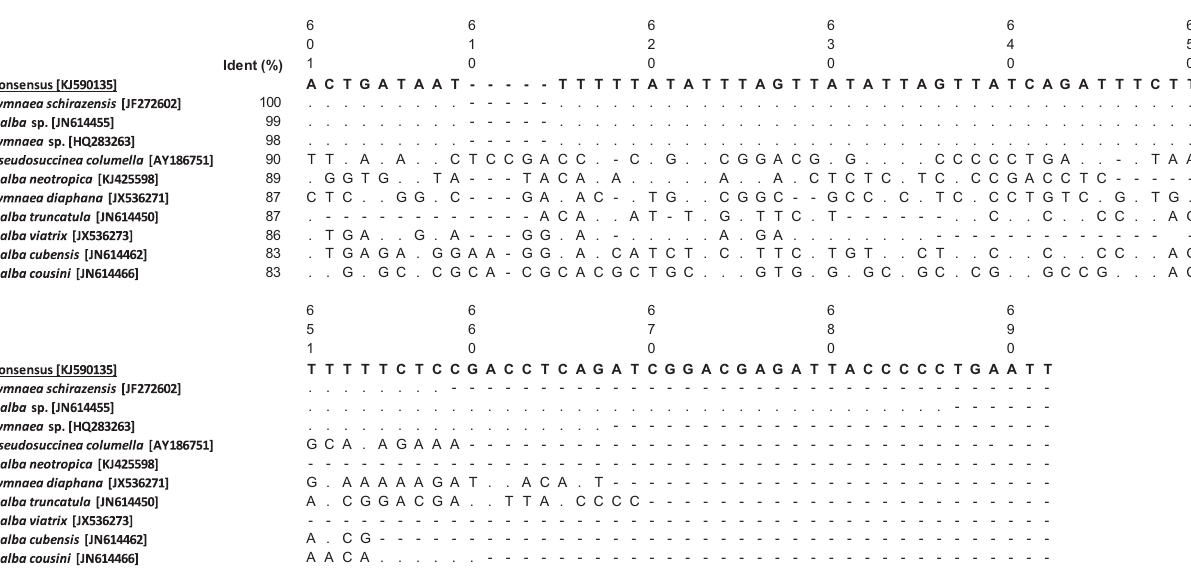
Figure 1. Sequence alignments of the ITS-2 sequences (5 0 –3 0 ) of Lymnaeidae retrieved from the BLASTN analysis of Lymnaeidae found in South America. Ident is for Identity; dot (.) indicates conservation; hyphen (-) indicates alignment gap; a letter indicates substitution.